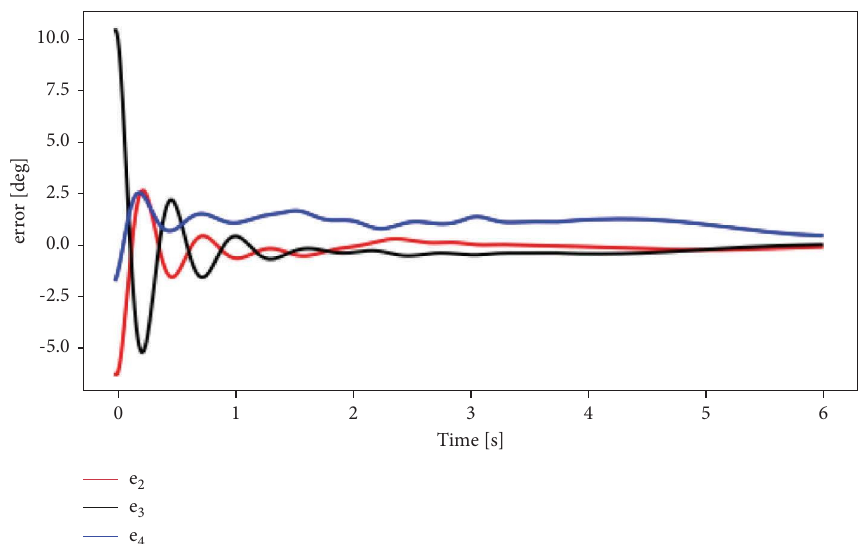
Figure 10: Trajectory tracking error using imperfect inverse